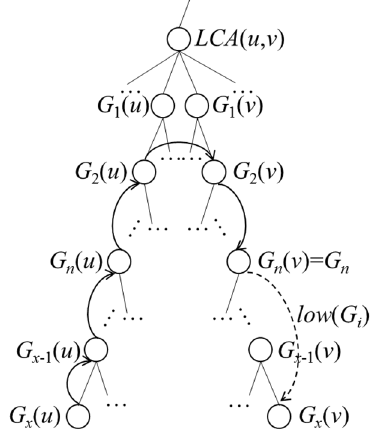
Figure 7. Case 2 of lowDist ( G i , u ).